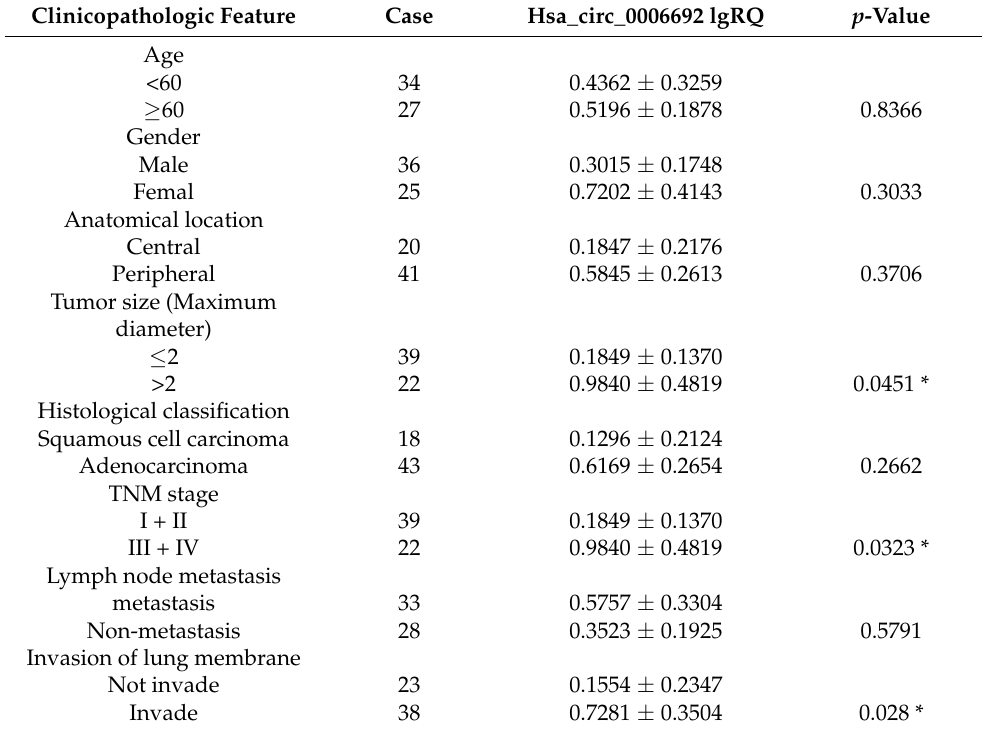
Table 1. Association between hsa_circ_0006692 expression and clinicopathologic